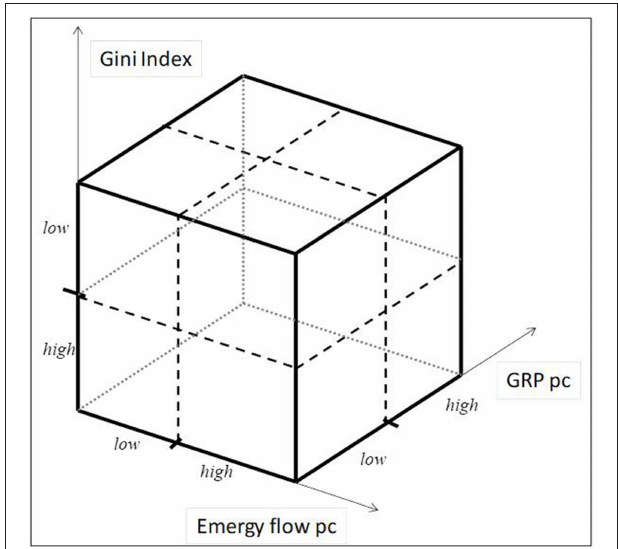
FIGURE 3 | The three-axis diagram and the sub-cubes. The values for the three indicators are distributed along three equal segments divided into high and low domain by means of the median values. Eight sub-cubes are identified to facilitate categorization of systems.